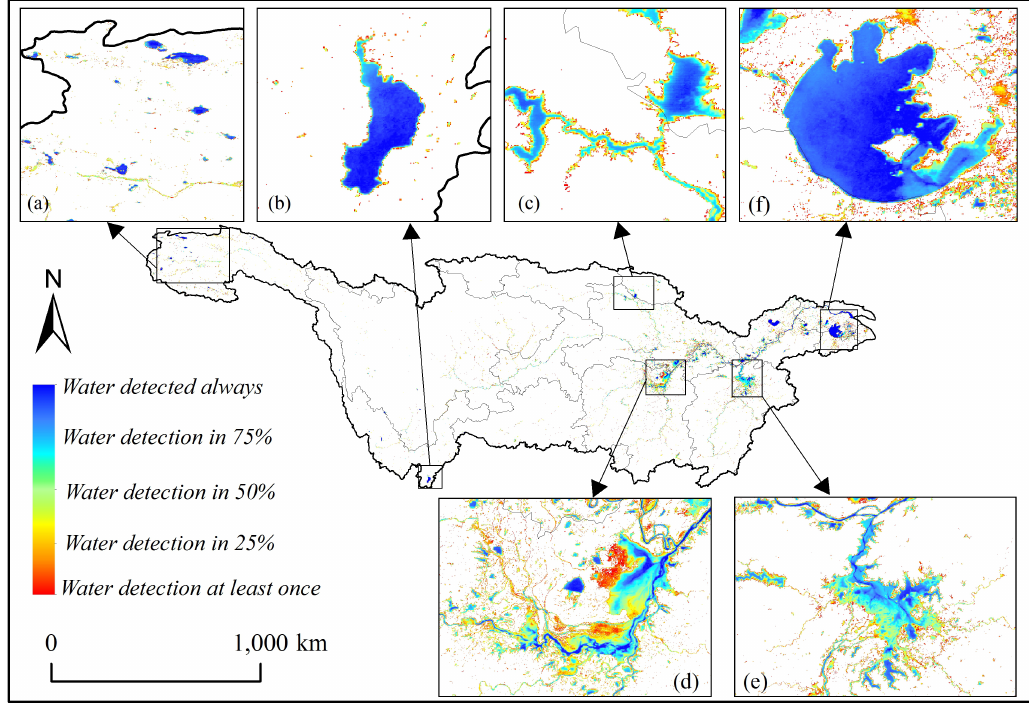
Figure 8. Surface water spatial distribution and inundation frequency 2000–2016 in YRB. ( a ) Source region of the Yangtze River; ( b ) Dianchi Lake; ( c ) Danjiangkou Reservoir; ( d ) Dongting Lake; ( e ) Poyang Lake; ( f ) Tai